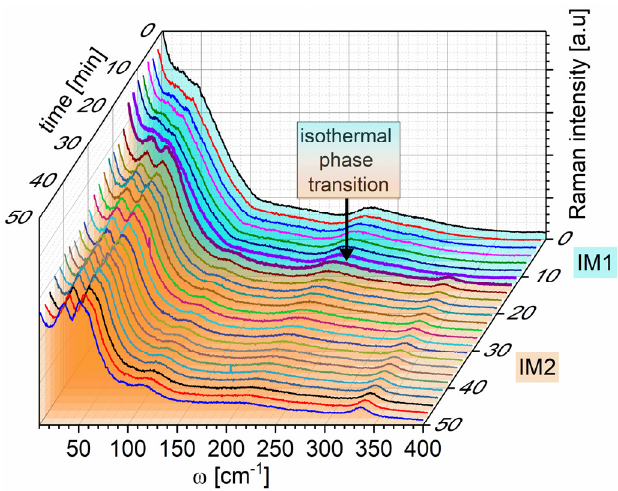
Figure 3. Time ‐ dependent evolution of Raman spectra for PbZrO 3 :0.1Nb single crystal at 233 °C. The line colors are only used to make it easier to distinguish spectra obtained at different times.